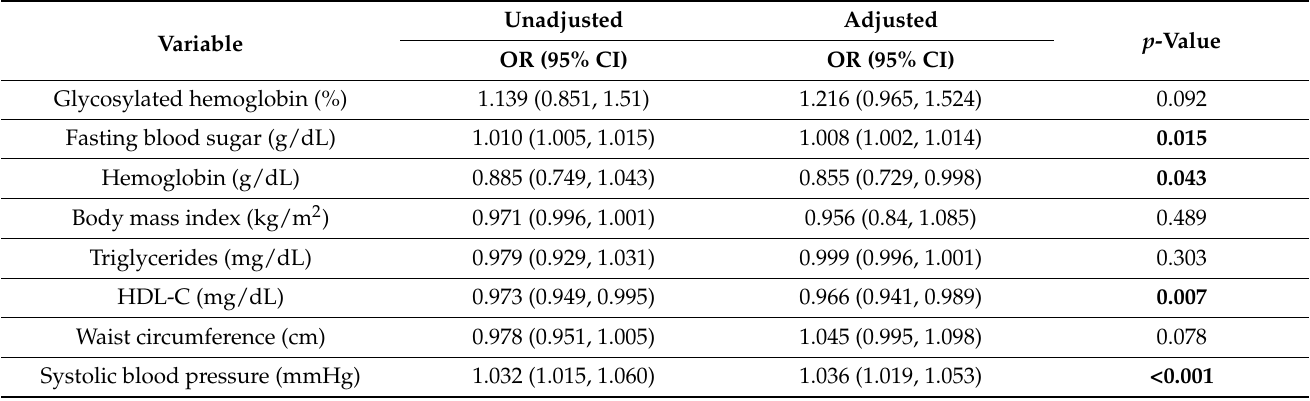
Table 3. Odds ratios for the occurrence of